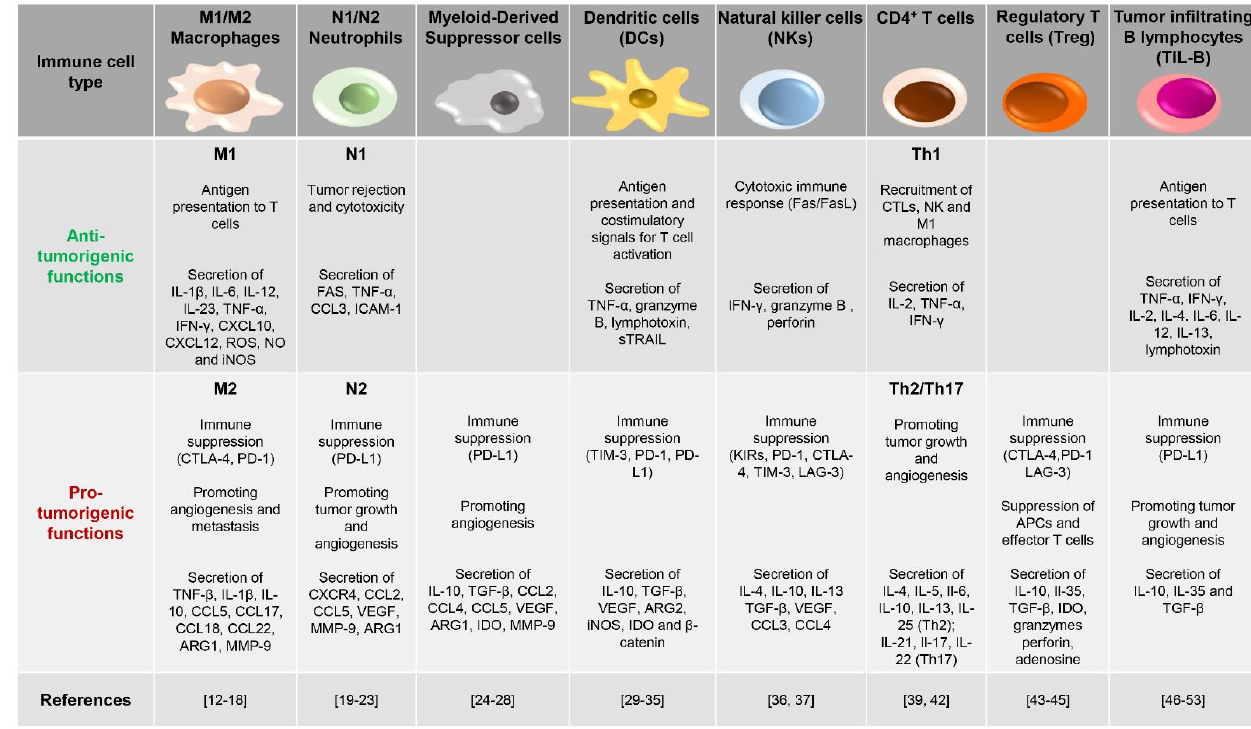
Figure 1. Schematic representation of key immune cells found in the tumor microenvironment. Depending on the tumoral context, immune cells exert either anti-tumorigenic or pro-tumorigenic functions. The balance between these two opposite functions determines the outcome of the immune response against cancer.